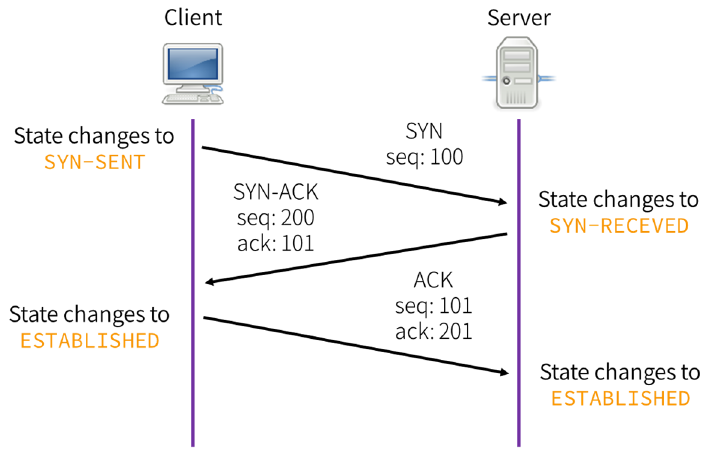
Figure 1. TCP three ‐ way handshake diagram. TCP, Transmission Control Protocol; SYN, Figure 1. TCP three-way handshake diagram. TCP, Transmission Control Protocol; SYN,